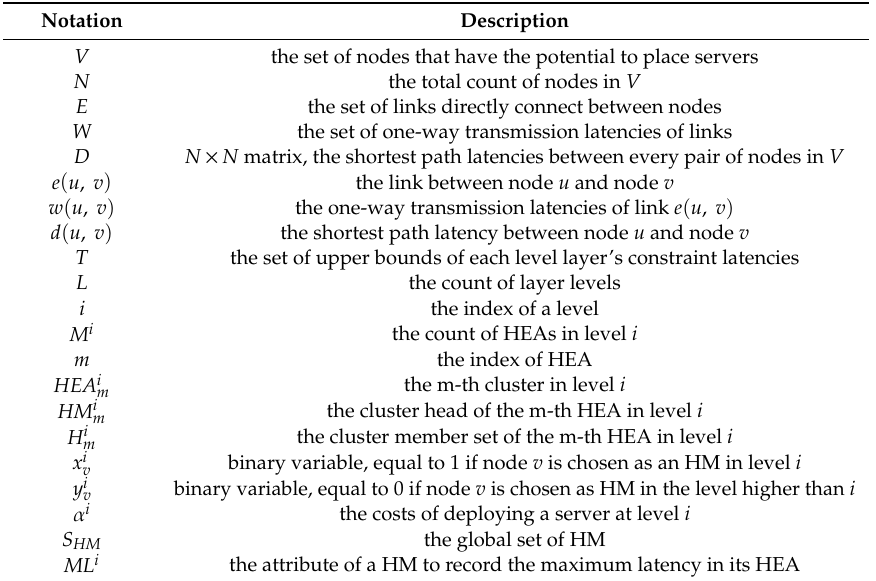
Table 1. Summary of